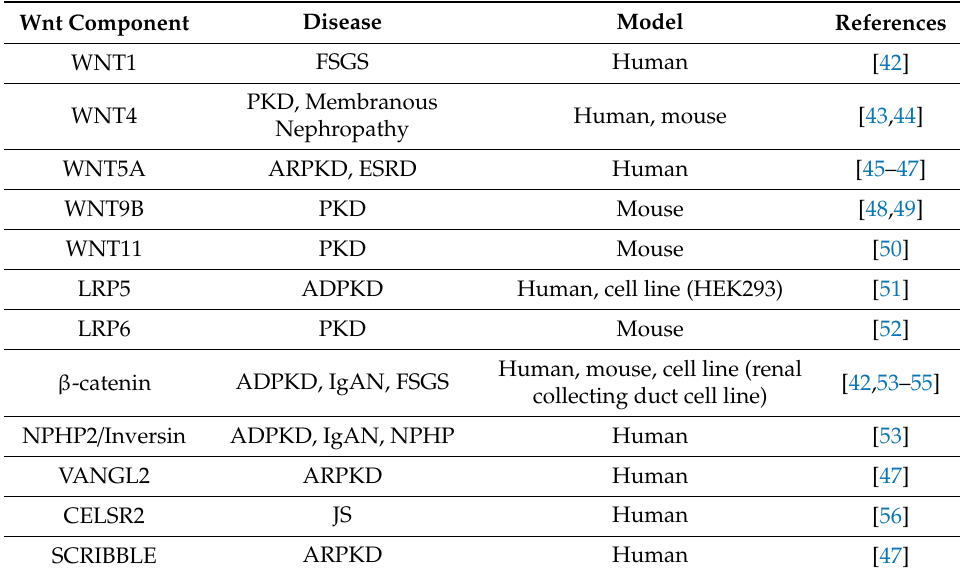
Table 2. Wnt components have roles in various chronic kidney diseases